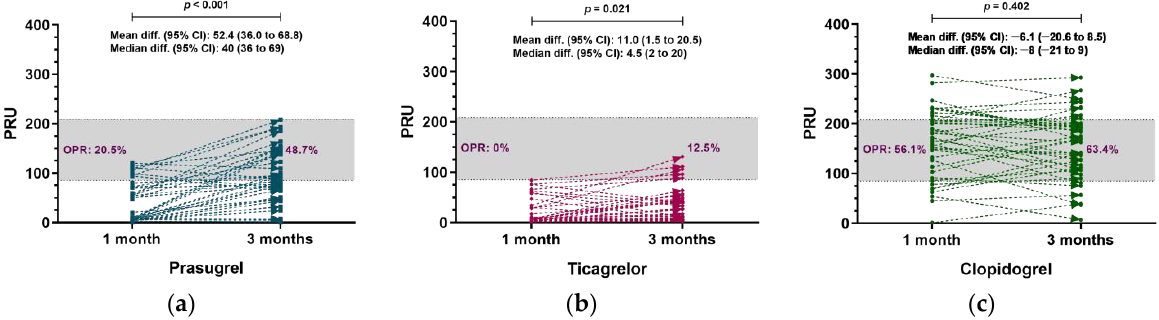
Figure 2. Matched-pairs analysis of 1 month versus 3-month pharmacodynamics in each P2Y12 inhibitor group. ( a ) Prasugrel; ( b ) ticagrelor; ( c ) clopidogrel.